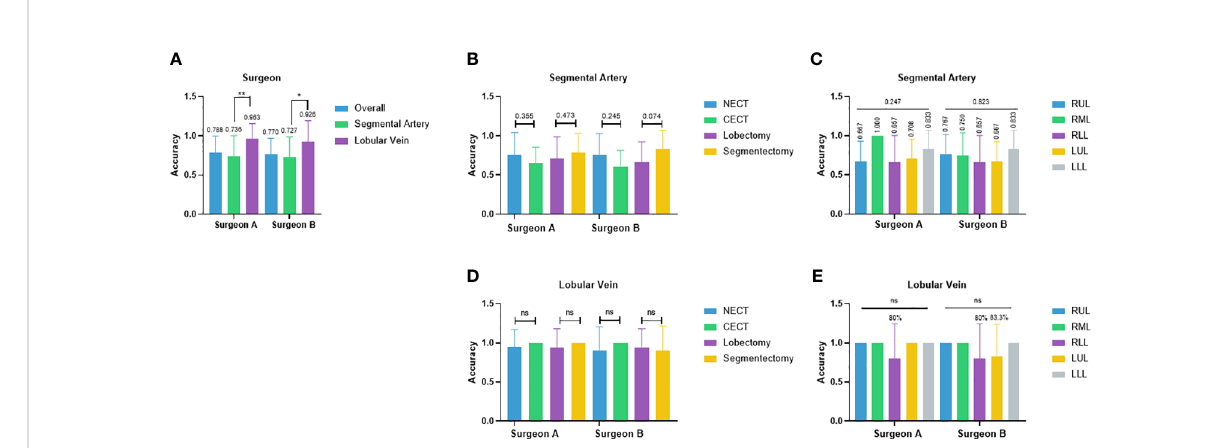
FIGURE 3 Performance of two junior thoracic surgery attendings. (A) Case-wise overall accuracy and accuracy in arteries and veins; (B) Artery accuracy comparison between contrast and non-contrast CT, lobectomy, and segmentectomy; (C) artery accuracy comparison between different lobes; (D) vein accuracy comparison between contrast and non-contrast CT, lobectomy, and segmentectomy; (E) vein accuracy comparison between different lobes. NECT, non-enhanced CT; CECT, contrast-enhanced CT; RUL, right-upper lobe; RML, right-middle lobe; RLL, right-lower lobe;